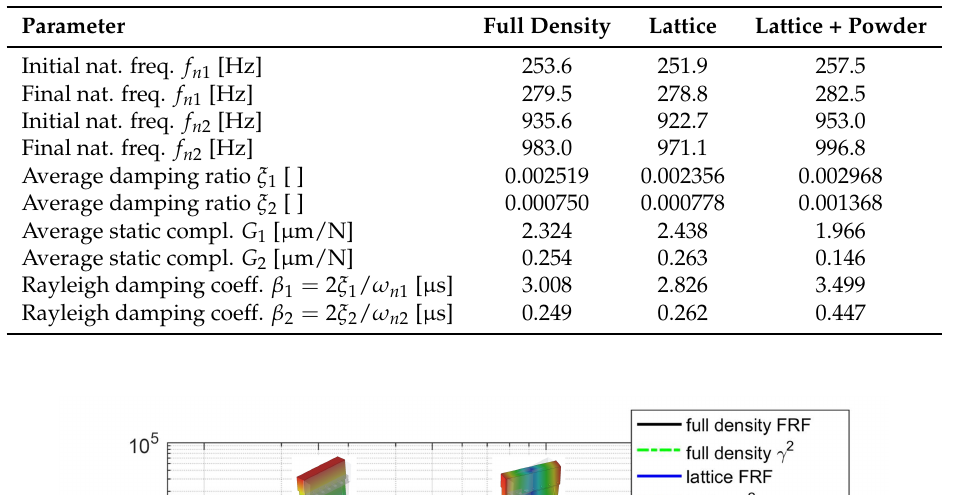
Table 2. Modal parameters.